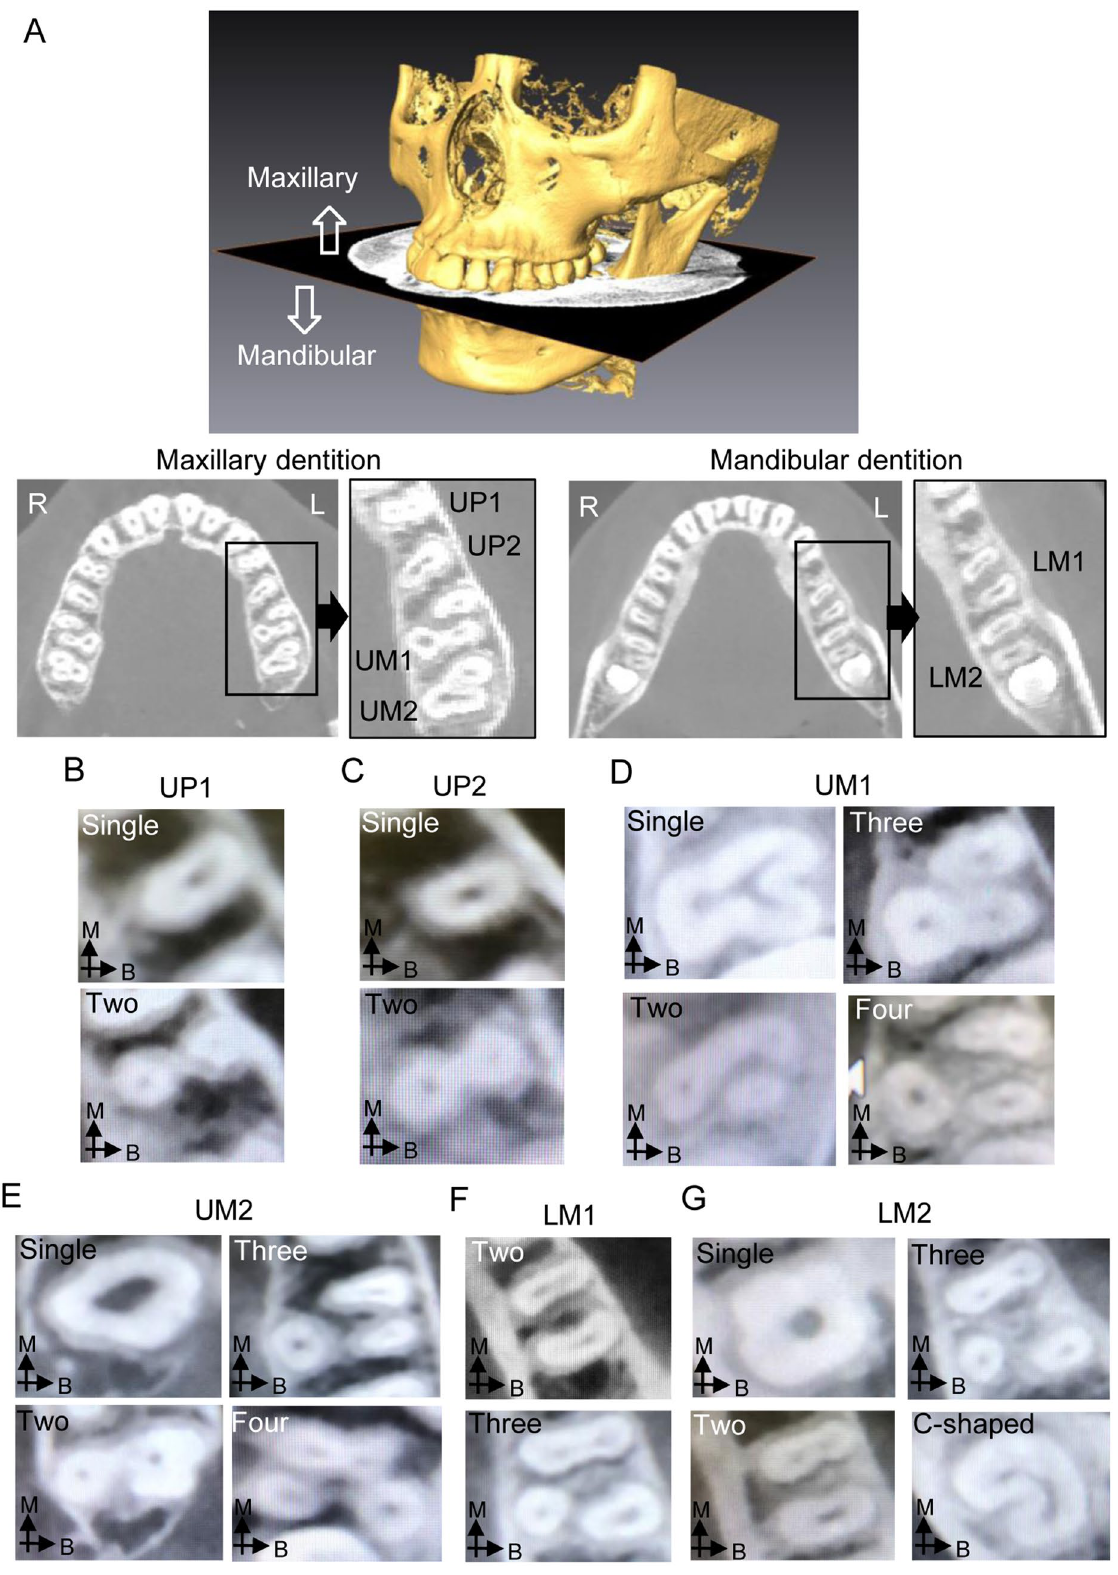
Figure 1. Observation of tooth root morphology using CT. ( A ) Reconstruction of the three-dimensional surface and the occlusal plane (OP) using Amira ver 6.0.0. The number and shape of roots in the maxillary and mandibular teeth were observed in slice images parallel to the OP. ( B – G ) Examples of the tooth root morphology observed in UP1s ( B ), UP2s ( C ), UM1s ( D ), UM2s ( E ), LM1s ( F ), and LM2s ( G ). The arrows indicate the buccal ( B ) and mesial ( M )